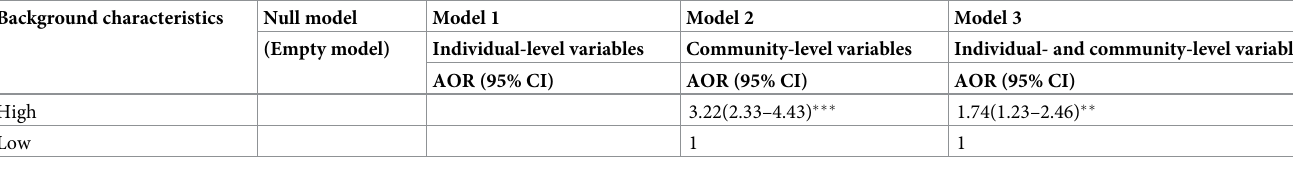
S1 Fig. The global spatial autocorrelation based on feature locations and attribute values of unsafe child stool disposal in Ethiopia, EDHS